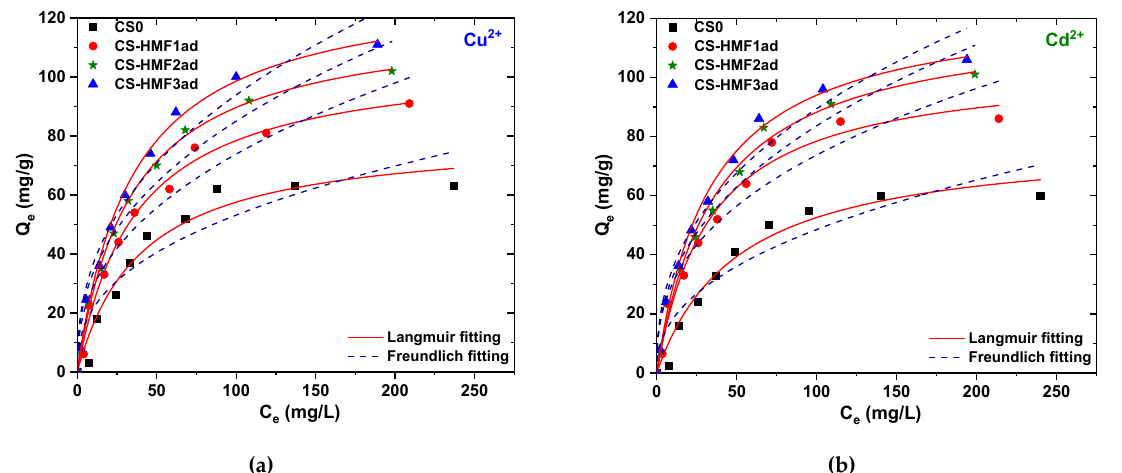
Figure 9 . Equilibrium data ( T = 25 °C) for the removal ( a ) Cu 2+ and ( b ) Cd 2+ by CS0, Figure 9. Equilibrium data ( T = 25 ◦ C) for the removal ( a ) Cu 2 + and ( b ) Cd 2 + by CS0, CS-HMF1ad, CS-HMF1ad, CS-HMF2ad, CS-HMF3ad. Fitting to Langmuir and Freundlich equations. CS-HMF2ad, CS-HMF3ad. Fitting to Langmuir and Freundlich equations. Experimental conditions: Experimental conditions: C 0 = 10–300 mg/L, V = 20 mL, N = 160 rpm, T = 25 °C, t = 200 min, pH = C 0 = 10–300 mg / L, V = 20 mL, N = 160 rpm, T = 25 ◦ C, t = 200 min, pH = 5, m = 0.02 5, m = 0.02 g.